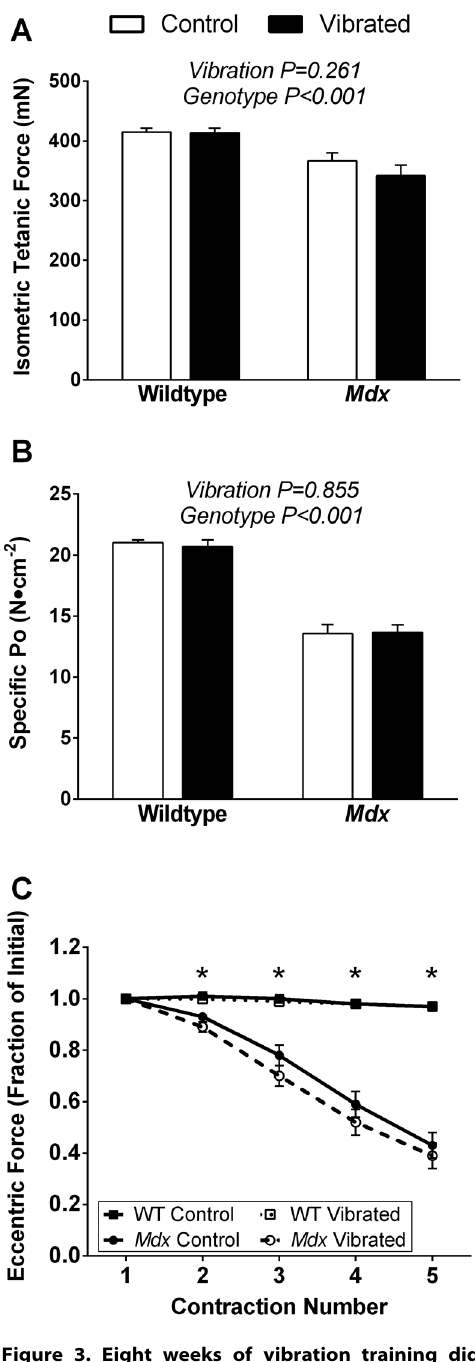
Figure 3. Eight weeks of vibration training did not impact exvivo EDL muscle contractile function. Vibration training for 8 weeks did not influence the following EDL muscle contractile measures: A) maximal isometric tetanic force production, B) specific force, or C) susceptibility to eccentric contraction-induced injury compared to non- vibrated mice. As expected, mdx mice had lower values for each of the three measurements of EDL muscle function compared to wildtype mice. Data are means 6 SE. P-values associated with the main effects of two-way ANOVAs are indicated above each set of bars in Panel A and B. In panel C, an interaction between genotype and eccentric contraction number was present, where the * signifies a significant (P , 0.05) difference between mdx and wildtype mice from post-hoc testing. Interactions between vibration and genotype for panels A and B P $